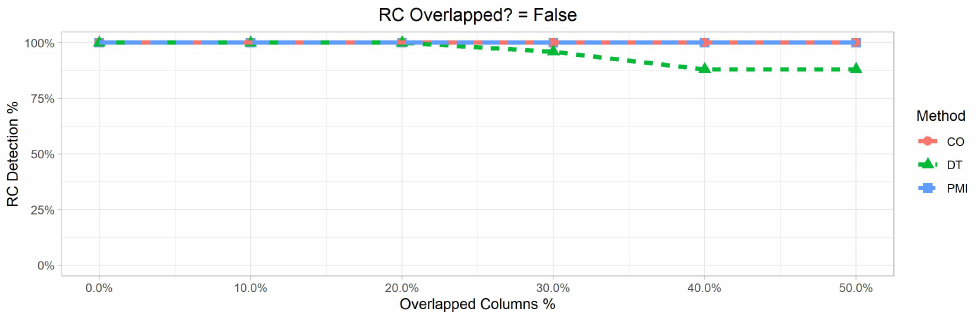
Figure 4. Results of the Mockup experiments when the root cause is in one of the overlapping factors.